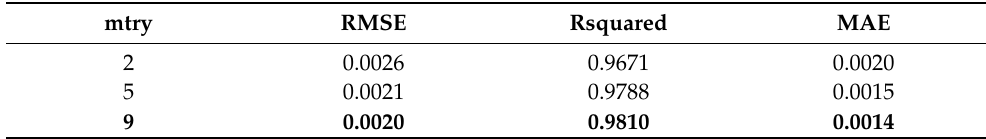
Table 8. Conditional inference random forest.